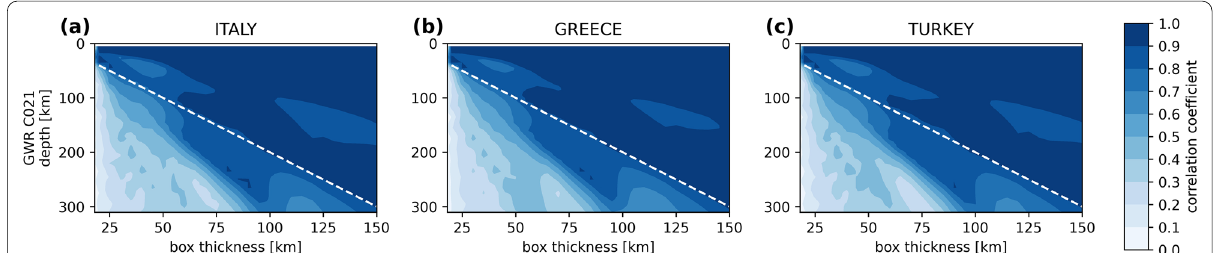
Fig. 9 The coefficient of correlation of original and recovered anomalies for the GWR C021 superconducting gravimeter (Membach) for three regions: Italy ( a ), Greece b and Western Turkey ( c ), respectively. The depth range of two uppermost anomalies is marked by dashed white lines